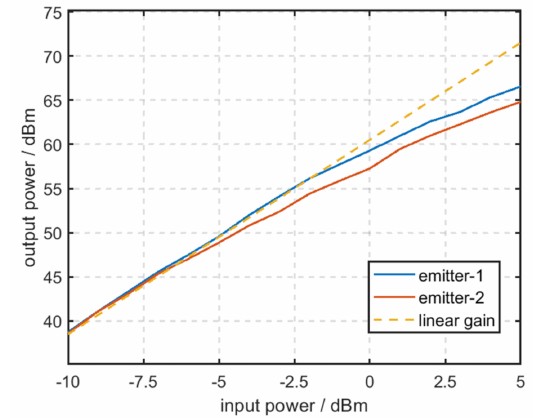
Figure 6. Actual gain curve of the RF amplifier